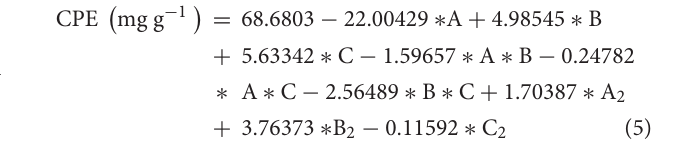
TABLE 1 | Experimental design and responses for optimizing CPE and total protein extraction. Run Factor 1 Factor 2 Factor